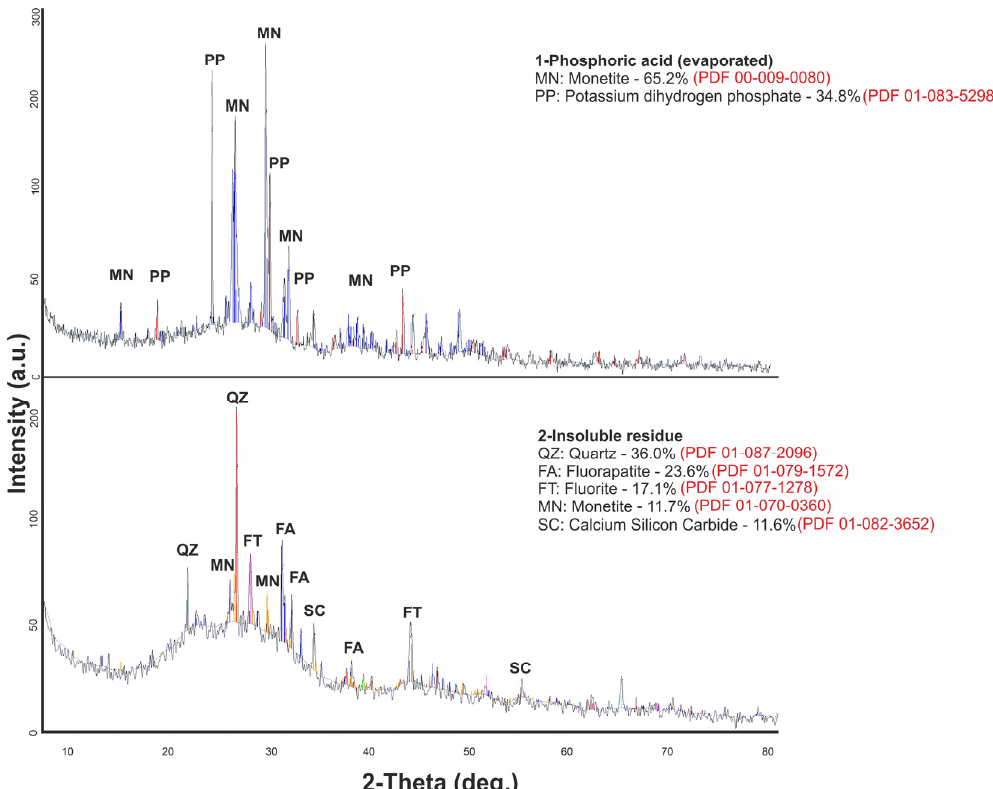
Figure 6. XRD patterns of phosphoric acid (evaporated) and insoluble residue. The XRD-identified compounds are monetite and potassium dihydrophosphate,